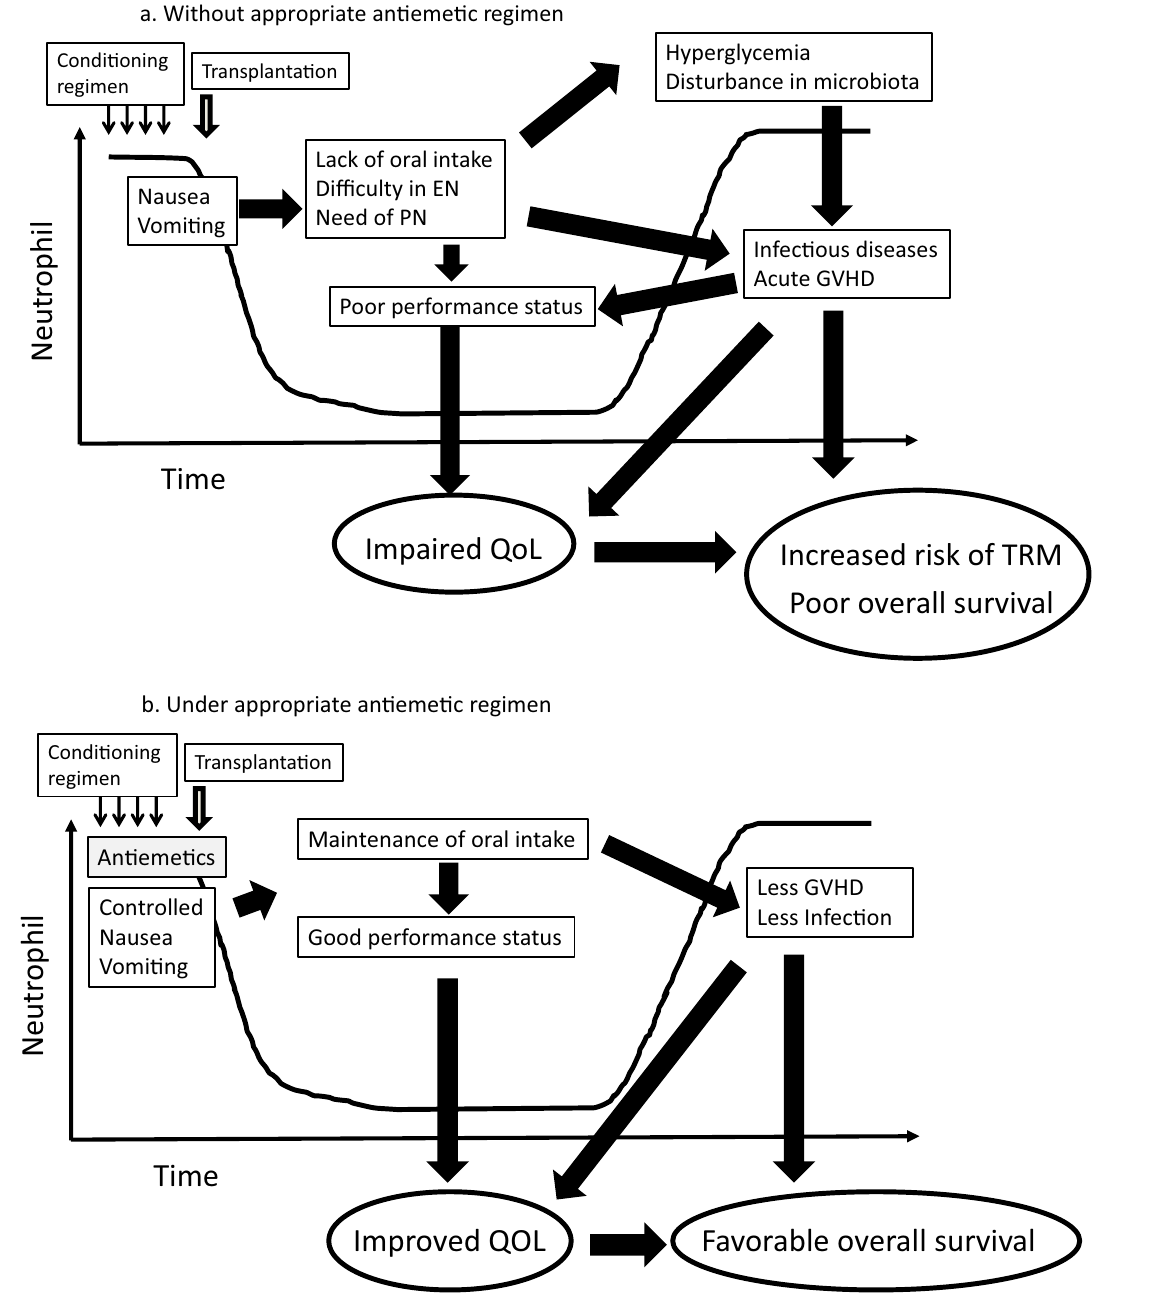
Fig. 1 Impact of antiemetics on the clinical outcome after HSCT a without appropriate antiemetic regimen, b under appropriate antiemetic regi- men. EN enteral nutrition, PN parenteral nutrition, GVHD graft-versus-host disease, QoL quality of life, TRM transplant-related